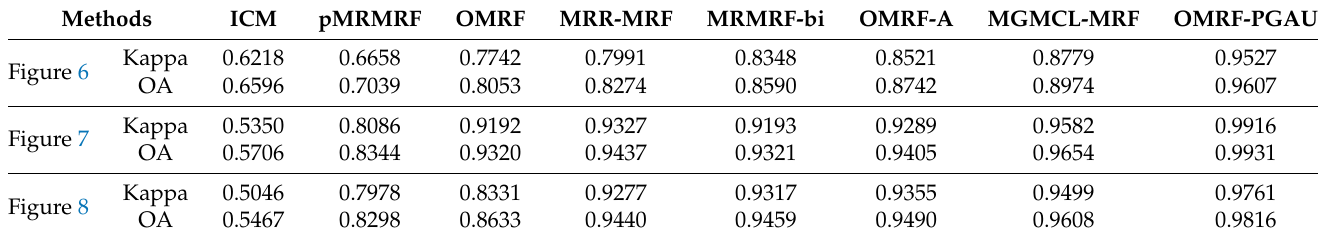
Table 1. Quantitative indicators of eight comparison methods for two texture